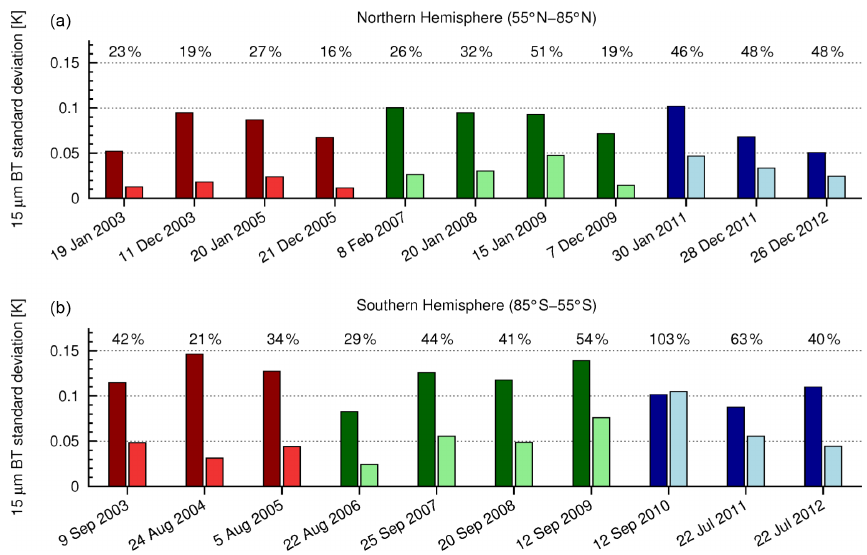
Figure 10. Peak events of gravity wave activity in individual 2003–2012 Northern and Southern Hemisphere winter seasons. The 15µm brightness temperature standard deviations were inferred from real AIRS measurements (dark shading) or simulations based on ECMWF operational analysis data (light shading). The color coding refers to the resolution of the ECMWF data (red is T511L60, green is T799L91, and blue is T1279L91). The percentages at the top of the plots indicate the relative differences of the simulated data with respect to the